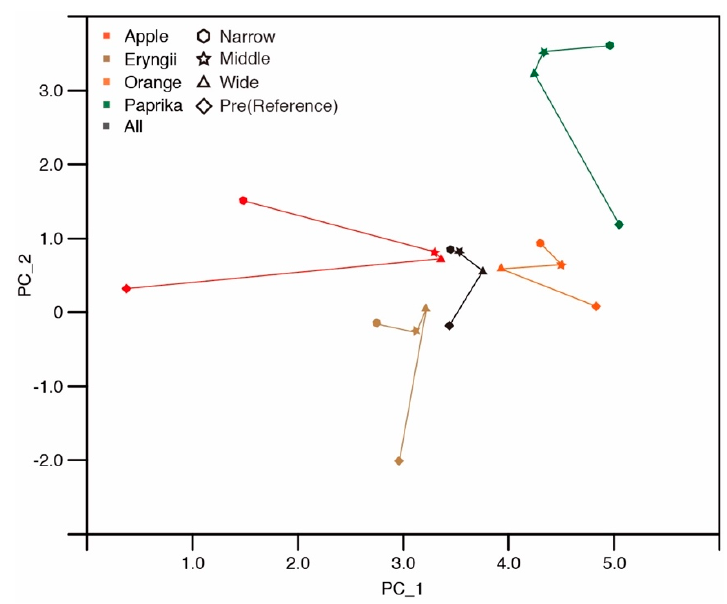
Figure 24. Distribution of the median of spotlight conditions on principal components.